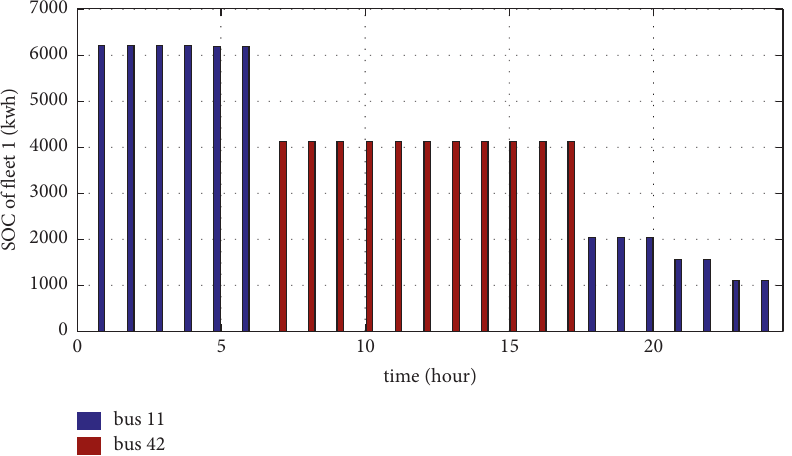
Figure 15: SOC of PEV fleet 1 in case 3 (the first scenario).